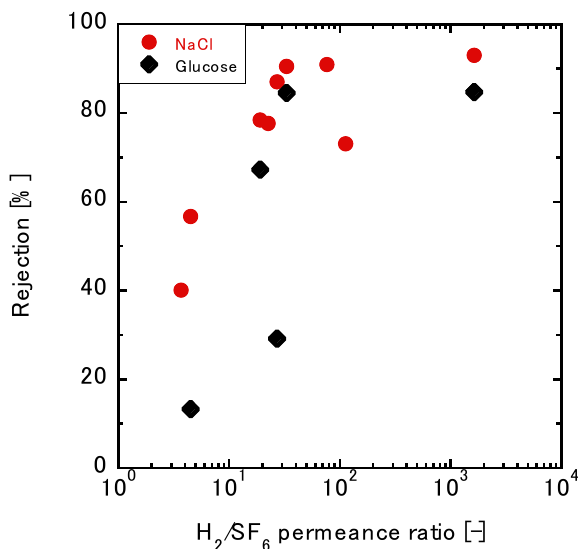
Figure 7. The relationship between the gas permeance ratio and the rejection of glucose through the TFPrTMOS-derived membrane.